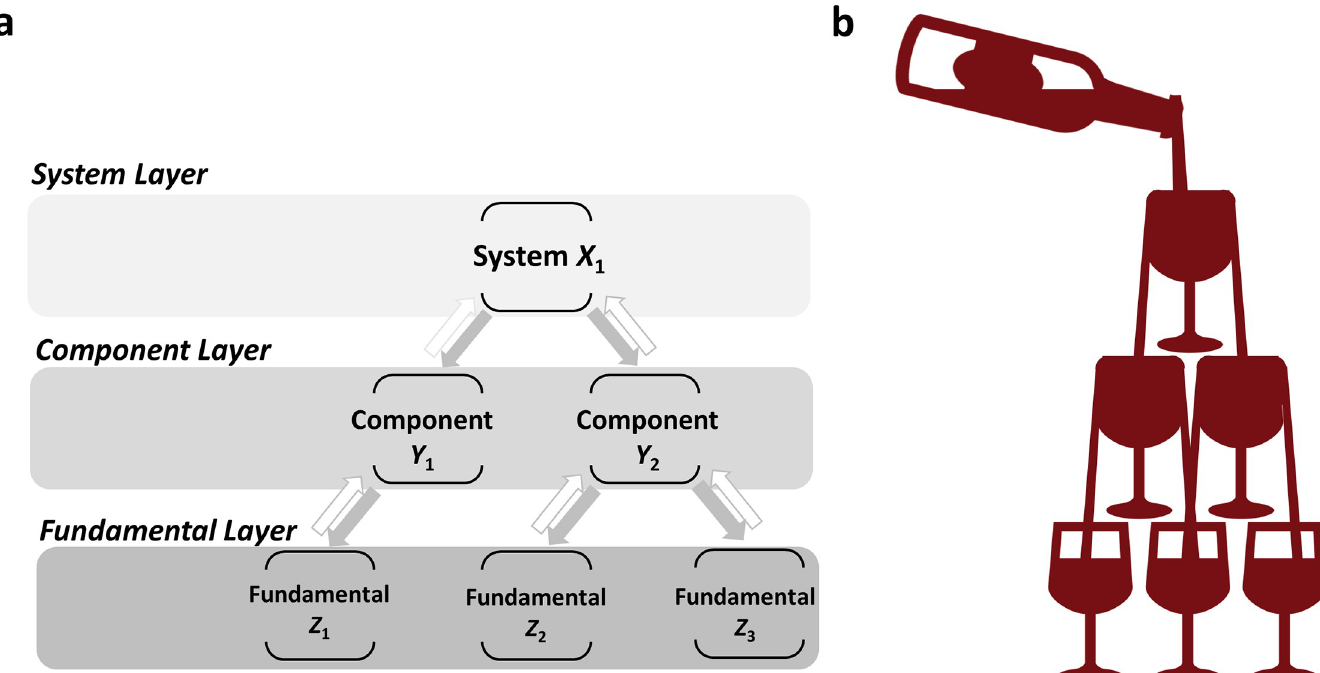
Fig 1. Hierarchical technology ecosystem and trickle-down effect in technology evolution. a, A typical technology ecosystem includes three layers, system layer, component layer, and fundamental layer. The grey arrows represent the trickle-down effect, while the white arrows denote the trickle-up effect in technology evolution. b, If trickle-down effect is significant in technology evolution, the improvement of system technology will drive and grow the performance of component and fundamental technologies.